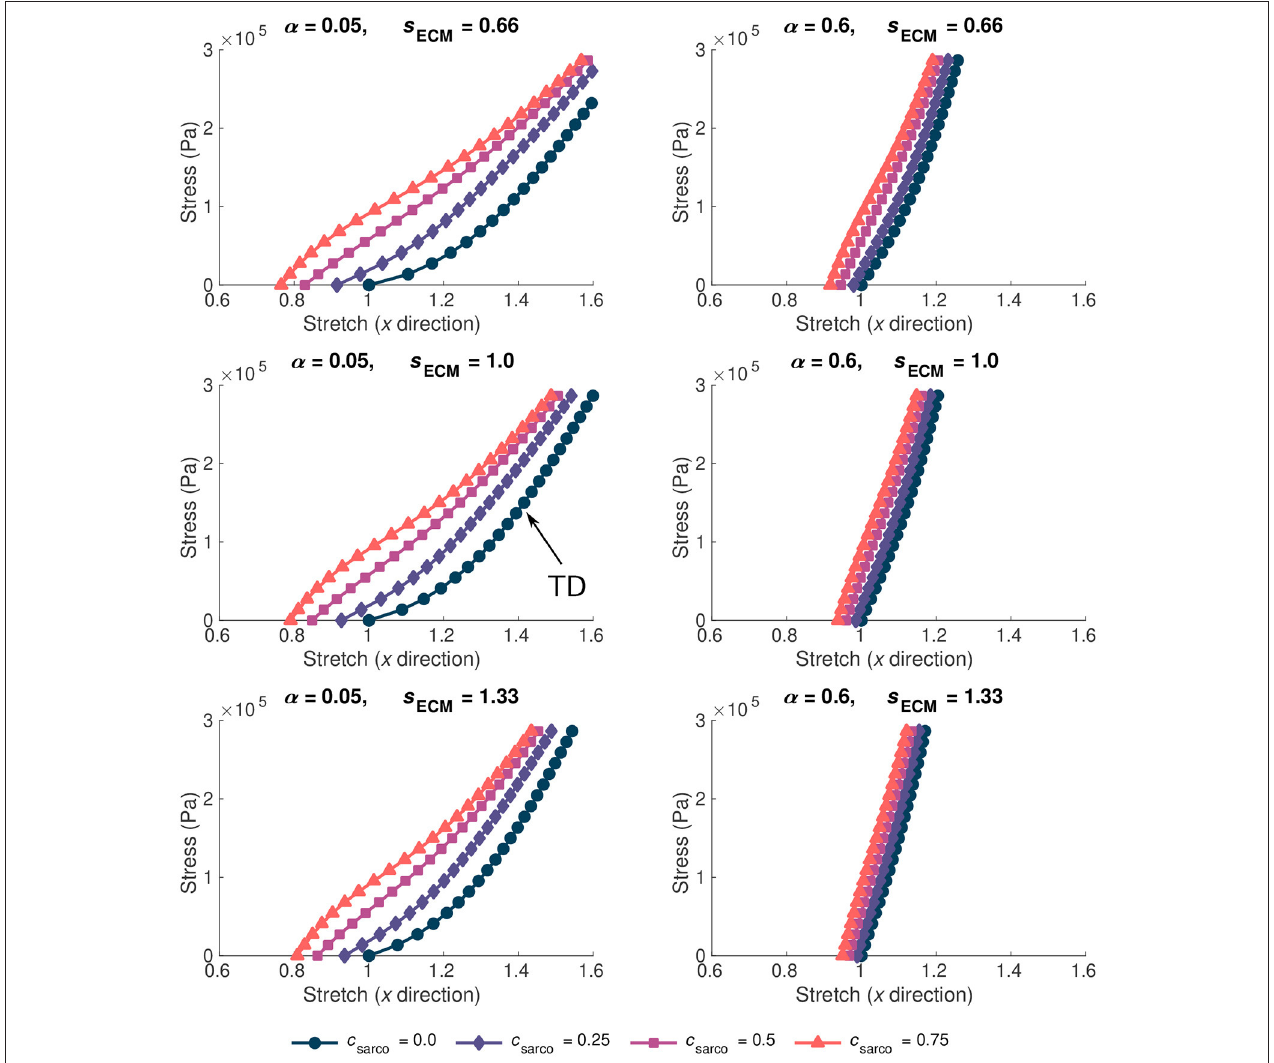
FIGURE 5 | Stress-stretch plot during passive lengthening of the muscle model for various values of ECM volume fraction, α , and stiffness, s ECM . The traction was linearly increased on the + x face of the muscle to 3 × 10 5 Pa, while the − x face was constrained in all directions. Individual lines on each plot represent a shift in sarcomere stretch by c sarco . Typically developed (TD) muscle has values of α = 0.05, s ECM = 1.0, and c sarco = 0.0, while cerebral palsy muscle could have a combination of α > 0.1, s ECM = 0.66 or 1.33, and c sarco >